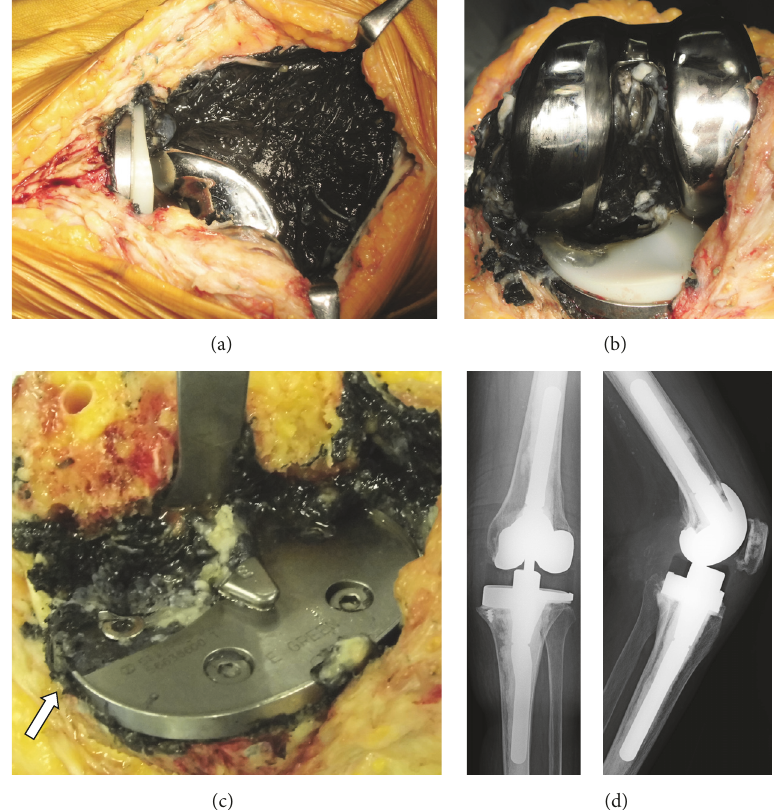
Figure 4: Gross appearance at revision surgery. (a) Severe metallosis is observed within the knee joint. (b) Polyethylene insert is heavily worn and broken at the posteromedial portion. (c) Coronal baseplate is fractured from the posteromedial corner to the posterior cruciate ligament recess (arrow). Subsidence of the posterior broken fragment of the baseplate is